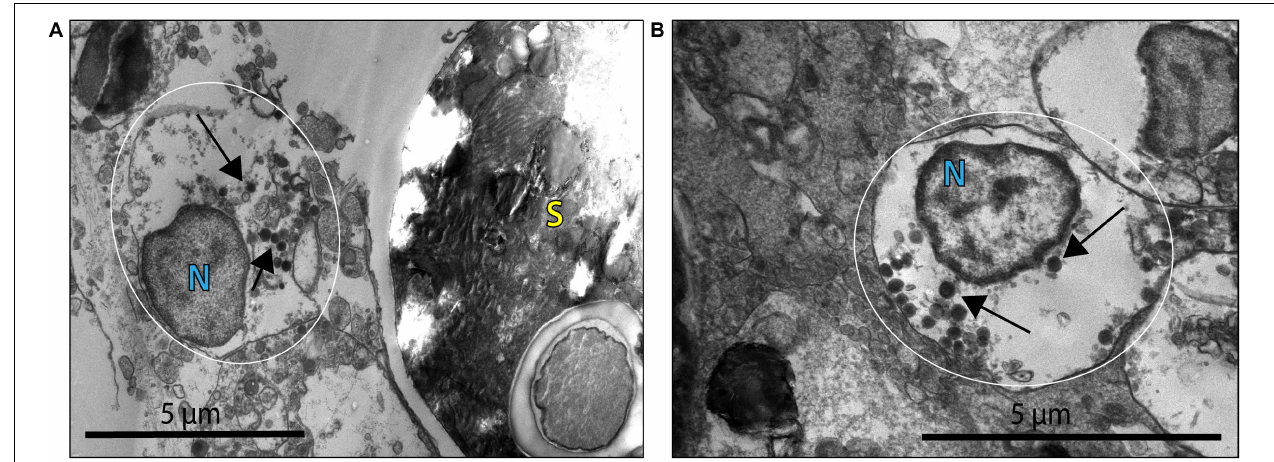
FIGURE 2 | Virus-like particles (VLP) indicated by black arrows within what may be a coral cell or viral factory [general placement of this structure is highlighted by the white circle; N denotes possible coral nuclei or a viral factory (VF)] associated with B coral cells. (A) VLPs ∼ 200–300 nm in diameter within an apparently necrotic coral cell or in proximity to a VF near a Symbiodiniaceae cell (S). (B) VLPs ∼ 260 nm in diameter within an apparently necrotic coral host cell or VF.